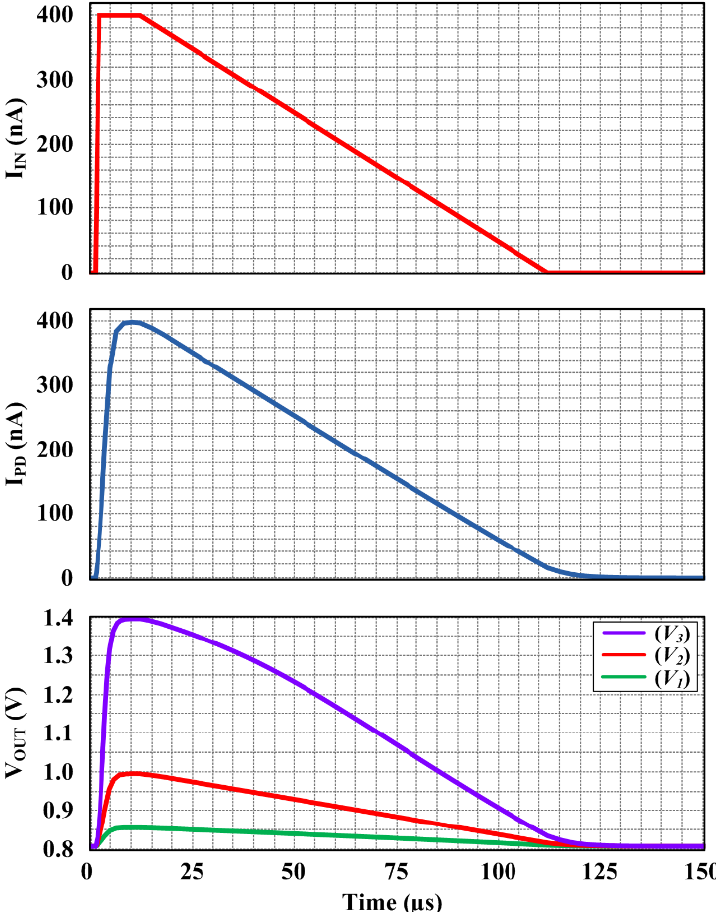
Figure 7. Upper panel: pulsed photocurrent I IN generated the PD. Middle panel: input pulsed current signal of the electronic circuit. Lower panel: circuit output voltage for different values of the circuit transimpedance gain.